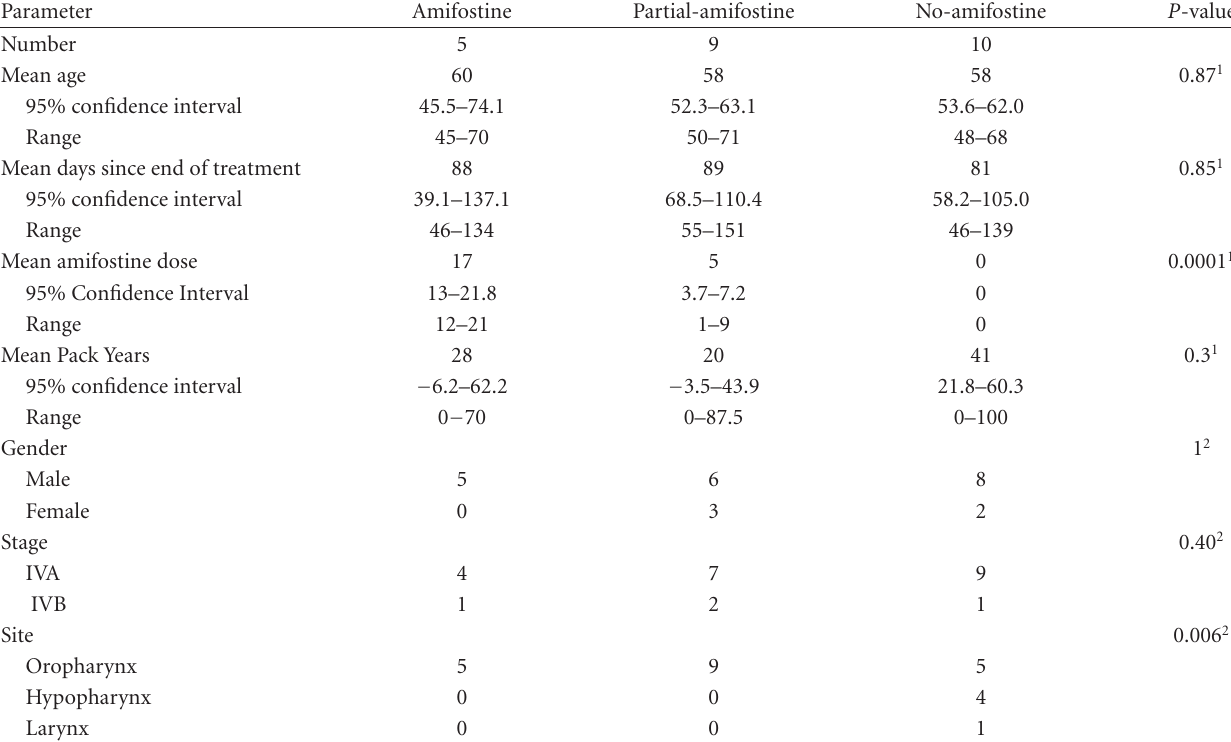
Table 1: Patient